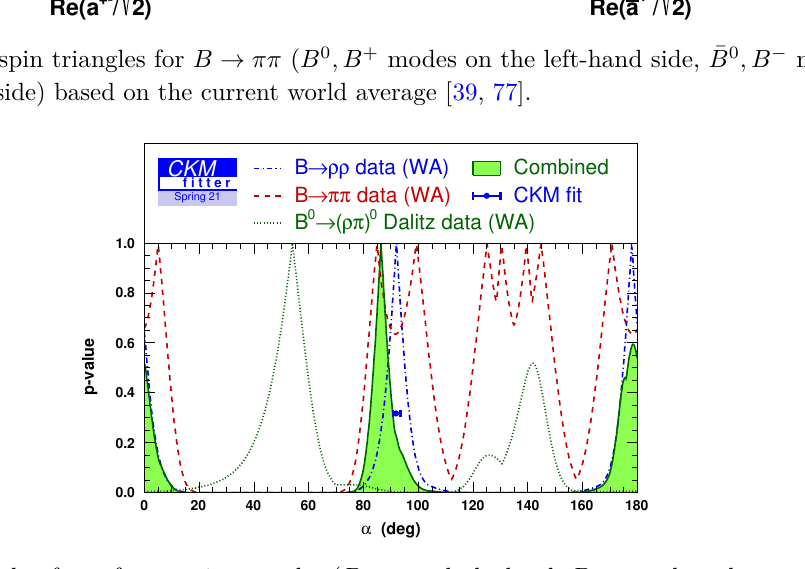
Figure 12 . p -value for α from various modes ( B → ππ dashed red, B → ρπ dotted green, B → ρρ dotted-dashed blue), from the combination of all modes (solid green) and the global fit prediction (blue interval) based on the current world average [39,